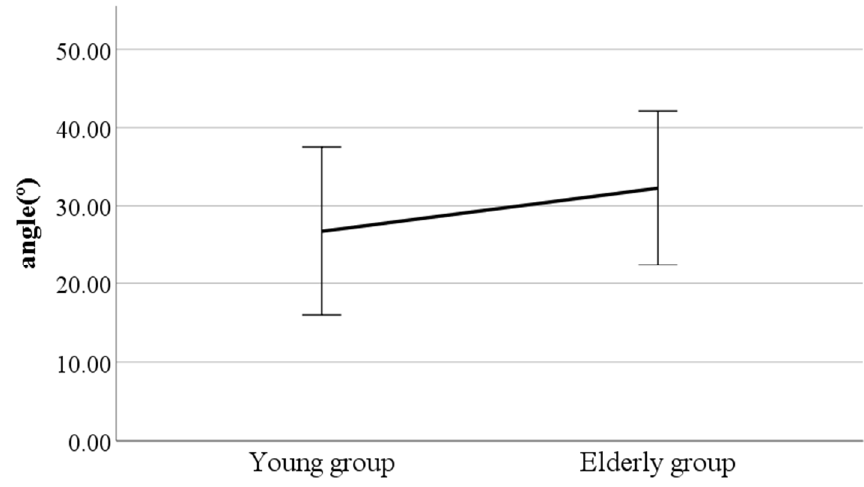
Figure 2. Age-to-age difference in double support phase (left foot forward) lateral flexion of the spinal column (F value: 2.31, DF: 289, p -value: 0.04).